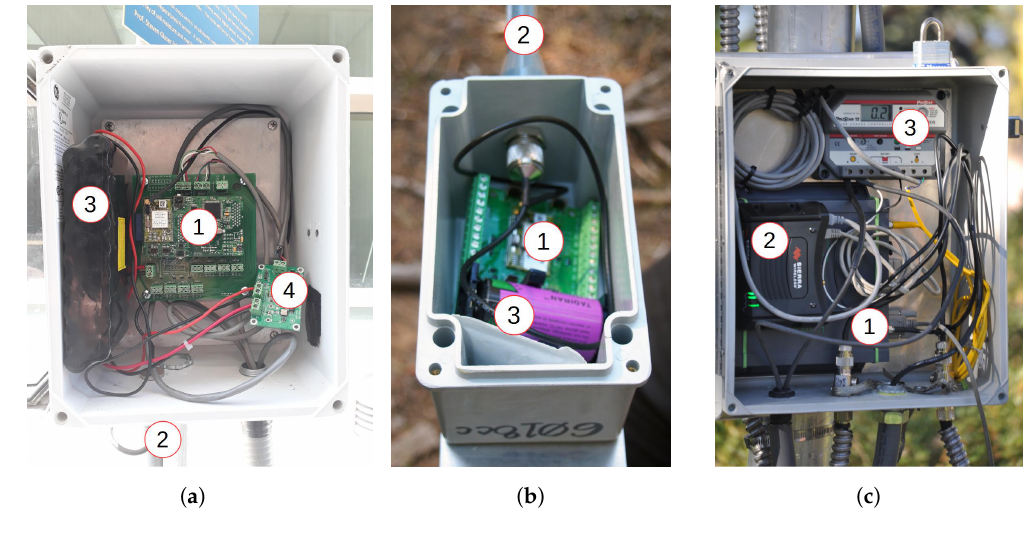
Figure 2. Contents of the electronics boxes: ( a ) Sensor station; ( b ) Repeater node; and ( c ) Base